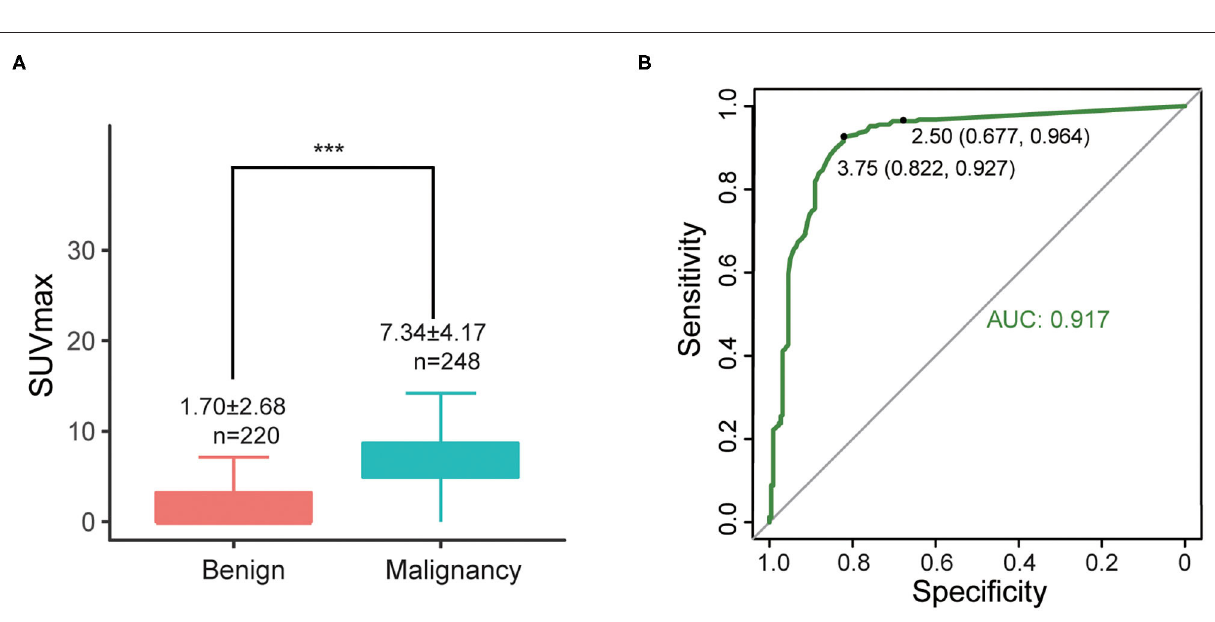
provided by PET/CT may lead to an improvement in the diagnostic accuracy of pancreatic lesions and in subsequent management of these patients ( Figures 6 , 7